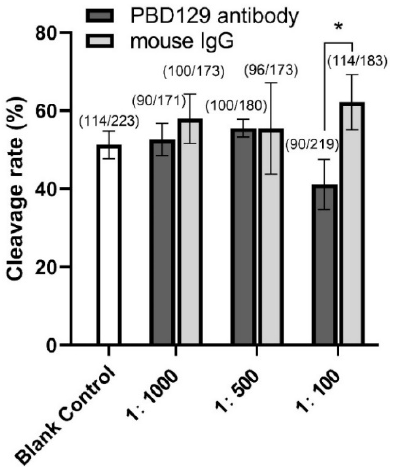
Figure 9. Effects of anti-pBD129 antibody treatment on sperm cleavage rate in in vitro fertilization (IVF). Sperm were co-incubated with sperm 1:100, 1:500, and 1:1000 diluted anti-pBD129 antibody for 30 min, and a relative concentration of anti-pBD129 antibody was added to the fertilization fluid. The corresponding concentrations of mouse IgG were co-incubated with sperm as a negative con- trol. Blank control was untreated. The total number of oocytes used in each group were noted above the column. Data are presented as the mean± SEM, n = 3. * p < 0.05.